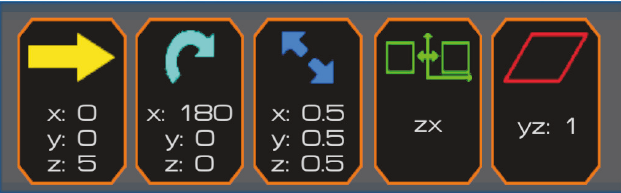
Figure 4: GEtiT displays an individual symbol in a specific color for each AT operation type. From left to right: translation, rotation, scale, reflection, and shear. On easy difficulty, a card’s values are indicated underneath the symbol.